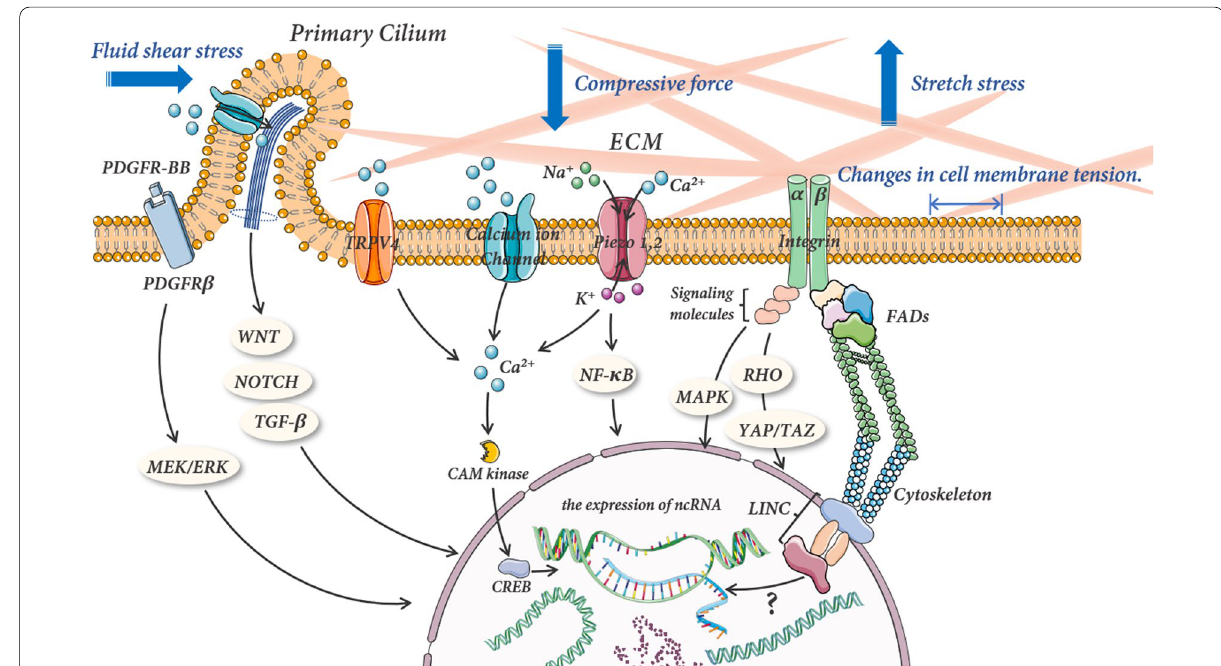
Fig. 3 The mechanical transduction of mechanical stimulation and its effect on the expression of ncRNA. Different types of mechanical stimuli modulate cell membrane tension and further motivate calcium channels and other cation channel opening via the ECM and primary cilia. Additionally, integrins could directly sense mechanical signals through the ECM, which alter the expression of ncRNA by the activation of downstream signal pathways and mechanical transmission of the